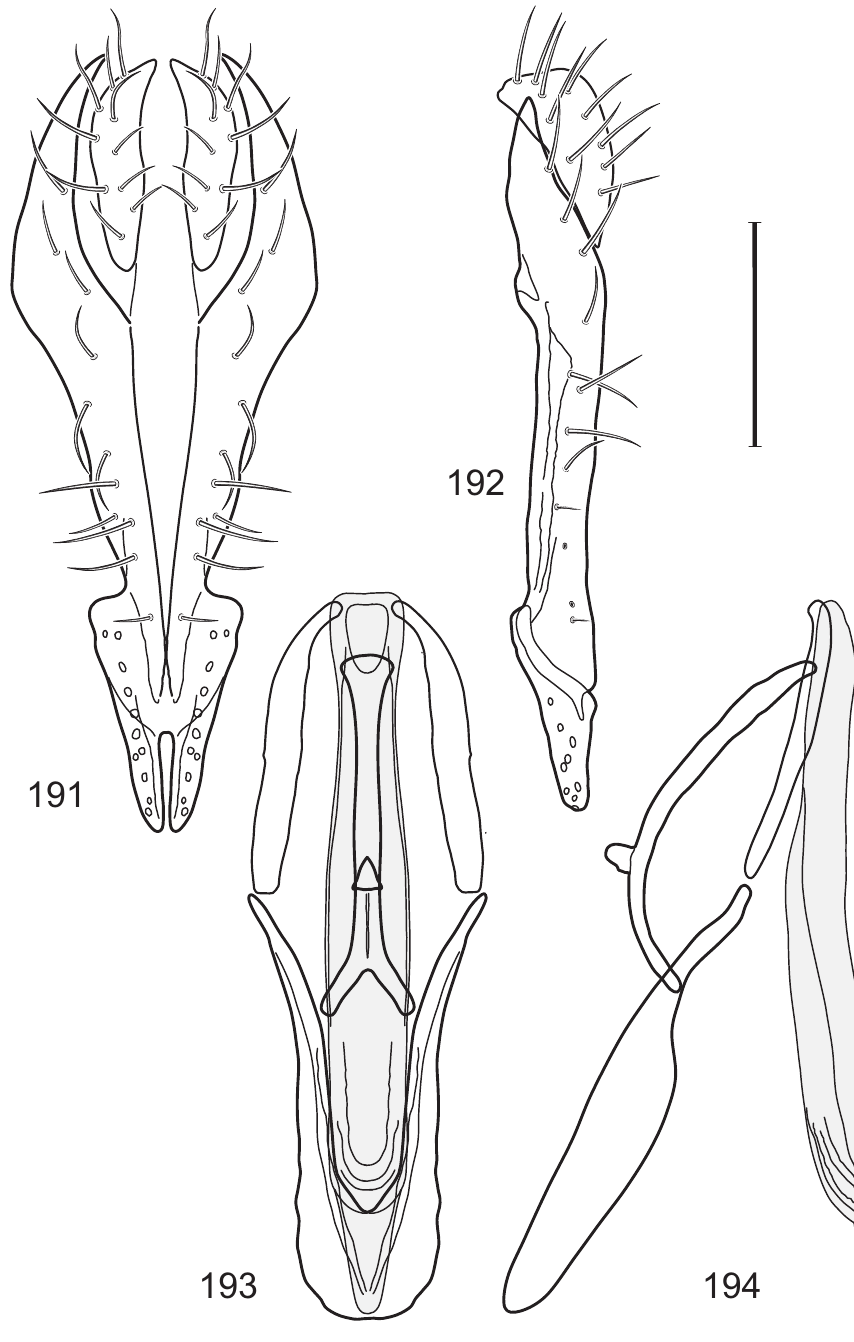
Figures 191–194. Hydrochasma sagittarium sp. n. (Brazil. Paraná: Morretes) 191 epandrium and cerci, posterior view 192 same, lateral view 193 internal structures of male terminalia (aedeagus [shaded], phal- lapodeme, gonite, hypandrium), ventral view 194 same, lateral view. Scale bar = 0.1